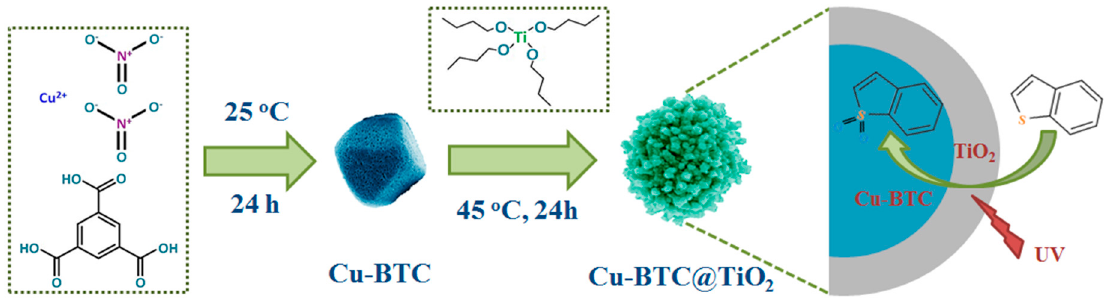
Figure 1. Schematic of mild synthesis of Cu-BTC@TiO 2 microspheres and their desulfurization performance.